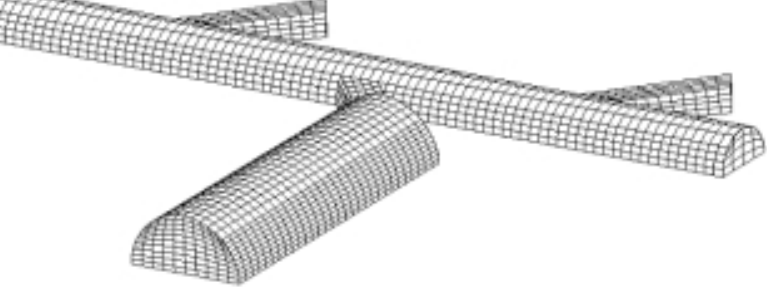
Fig. 5. Computational mesh for the tunnel model.